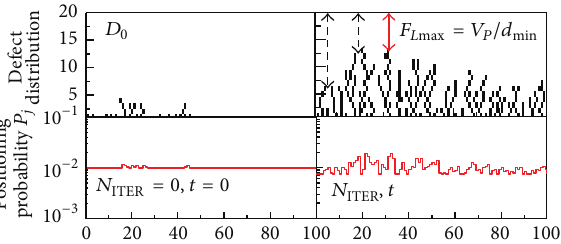
Figure 1: Sketch of the defect distribution in the oxide at two different iteration steps, represented by black cells in the 𝑛 × 𝑚 matrix of the mesh ( 𝑛 = 20 , 𝑚 = 100 ). The positioning probability 𝑃 𝑗 that a newly generated defect is located in column 𝑗 is also sketched.